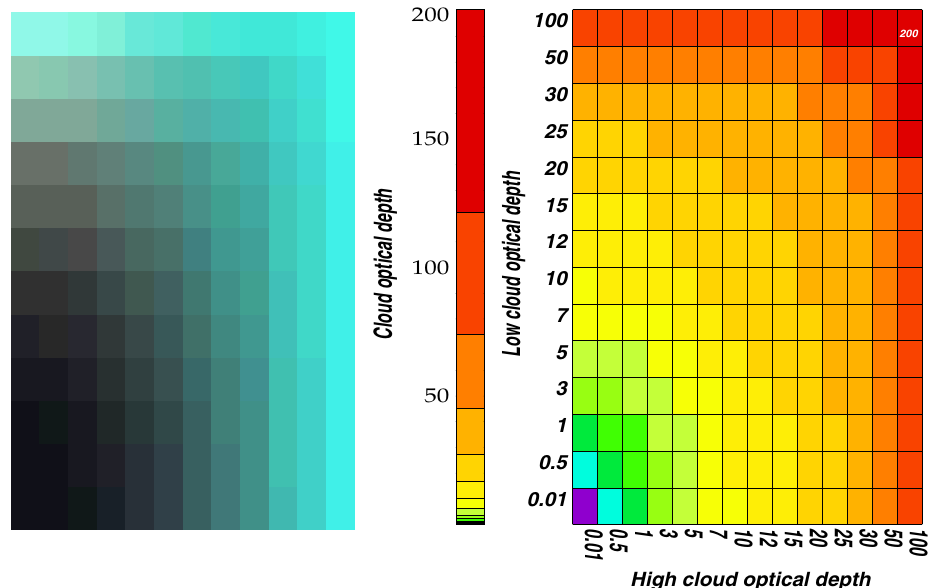
Fig. 3. False colour image of the simulated multi-layered cloud cases (left) and the simulated total optical depth (right). The optical depths simulated were 0.01, 0.5, 1, 3, 5, 7, 10, 12, 15, 20, 25, 30, 50, 100 for each layer.